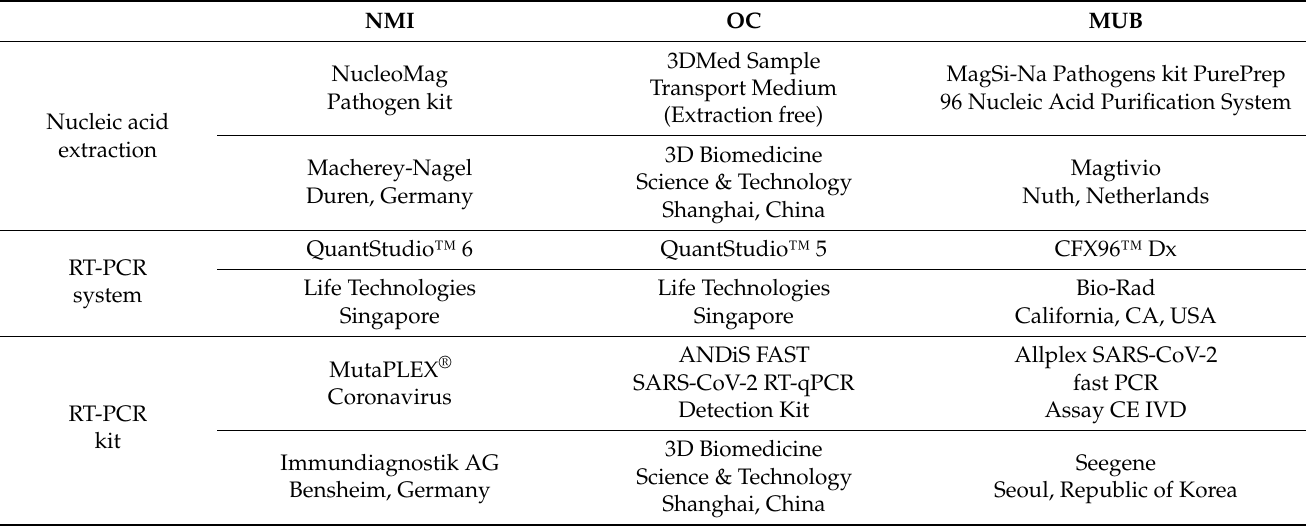
Table 1. Reagents and systems used in the reference method depending on